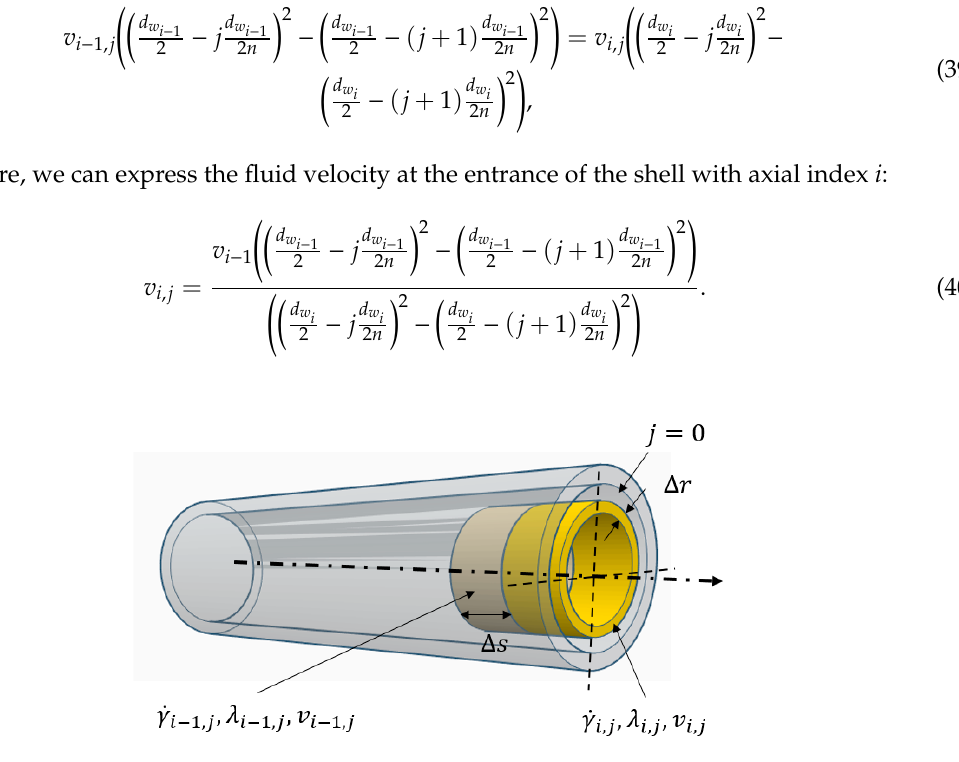
Figure 17. The conditions on a shell at abscissa position 𝑖 and radial position 𝑗 are influenced by the conditions at the preceding shell at position 𝑖 − 1 and 𝑗 .